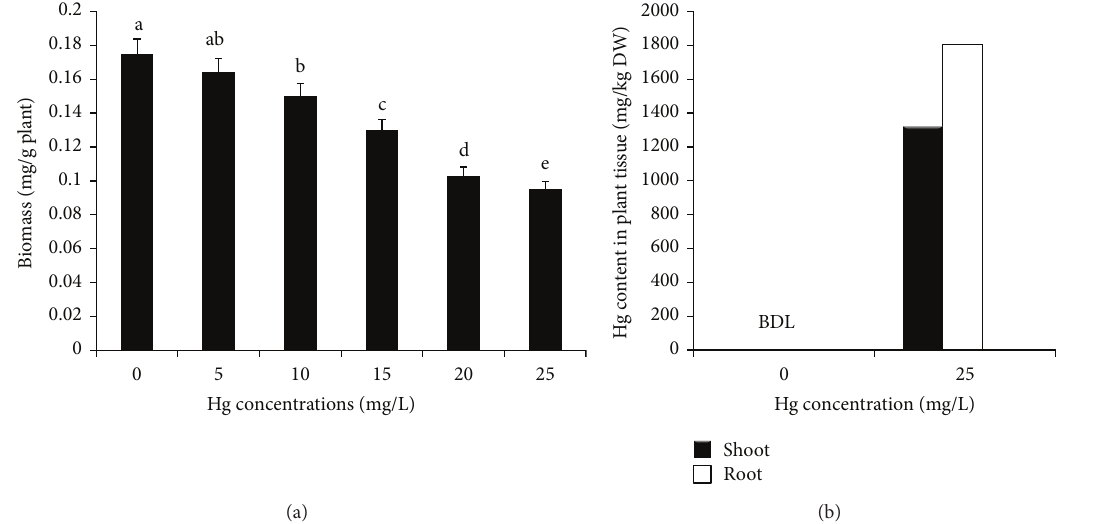
Figure 1: Biomass (a) and mercury accumulation (b) level in M. arvensis seedlings after 12 days of mercury treatment along with untreated control. Values are means ( 𝑛 = 3 ) ± SE; bars followed by the same letters are not significantly different for 𝑃 ≤ 0.05 according to the Duncan’s test; BDL: below detectable